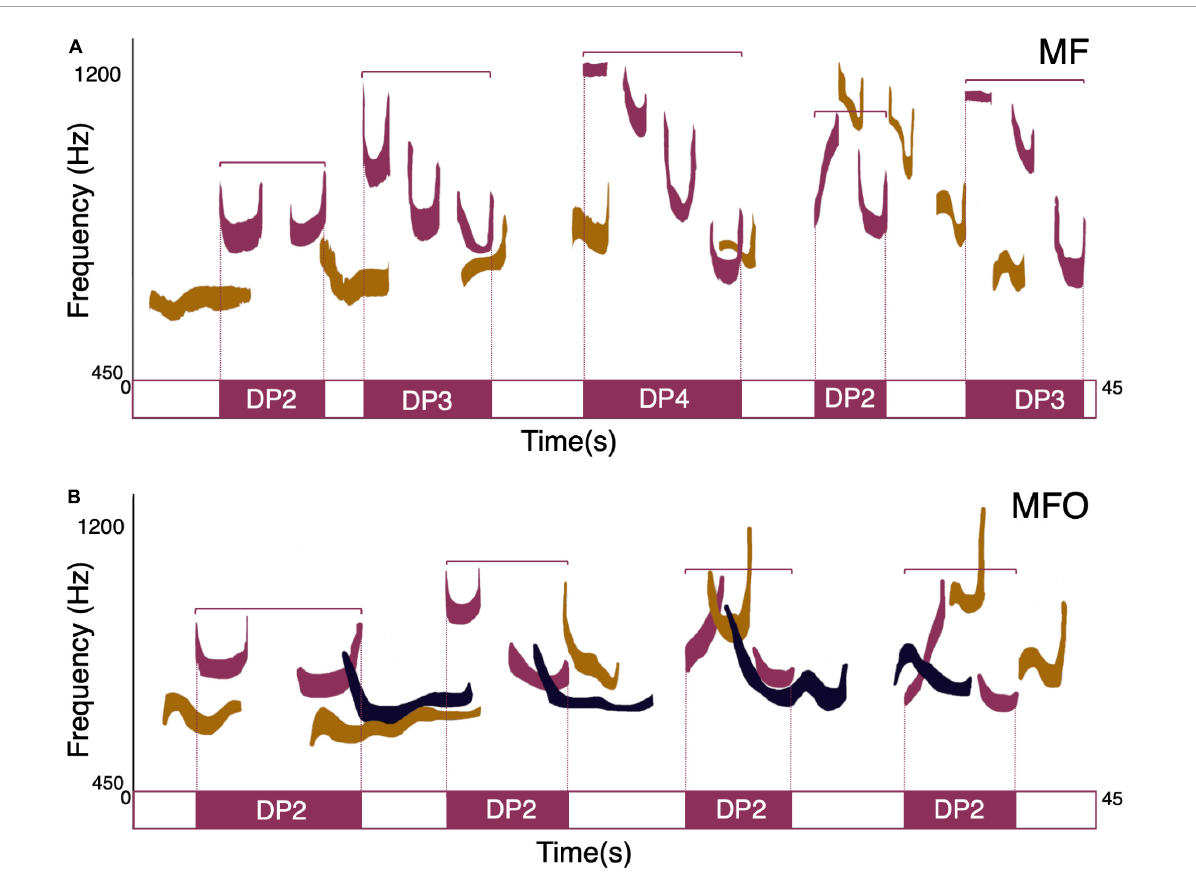
FIGURE4 Schematic representation of mothers’ different phrases’ concatenation in two different cosigning types. (A) Mother (in purple) duetting with their pair-mate (MF). (B) Mother singing with the pair-mate and one offspring (MFO). The fundamental frequency profile of mother’s, father’s, and offspring’s contribution to the song is highlighted in purple, light brown, and blue,